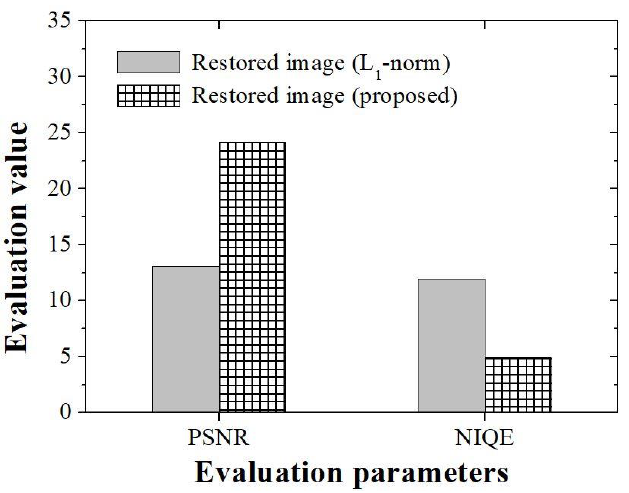
Figure 12. Graph of the evaluation parameters including the PSNR and NIQE using experimental image for l 1 -norm-based and proposed restoration methods.